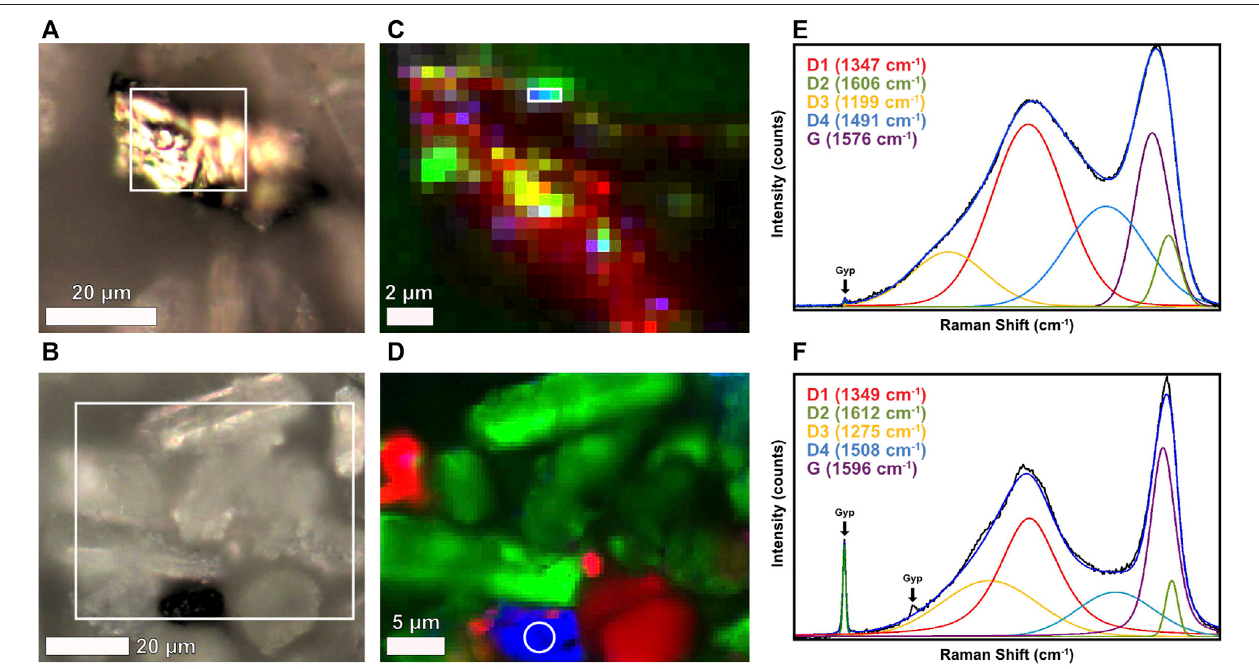
FIGURE4| RamanSpectroscopyofSampleT1.TworegionsfromsampleT1areshowninre fl ectedlightmicroscopyin (A) and (B) ;whiterectanglesin (A) and (B) show locations where Raman maps were collected (maps are presented in C and D , respectively). The map in C shows fi ts for pyrite (red; 375 – 380 cm − 1 ), gypsum (green; 1,000 – 1,010 cm − 1 ), and the G-band of organic carbon (blue; 1,500 – 1,650 cm − 1 ). The map in (D) shows fi ts for S 0 (red; 205 – 220 cm − 1 ), gypsum (green; 1,000 – 1,020 cm − 1 ), and the G-band of organic carbon (blue; 1,500 – 1,650 cm − 1 ). Averaged organic carbon spectra from the regions in the white rectangle in (C) and the white circle in (D) are plotted in (E) and (F) , respectively; results from peak fi tting of organic carbon D and G bands are also shown. Raman peaks from gypsum are also indicated ( “ Gyp ”